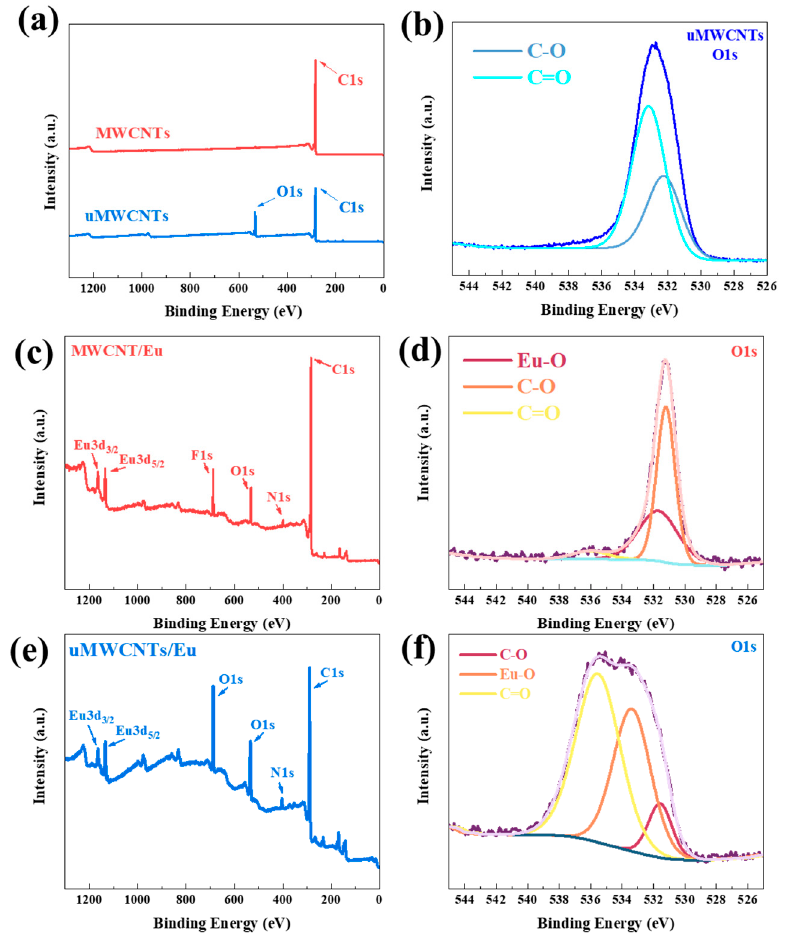
Figure 4. XPS spectra of MWCNTs ( a ); uMWCNTs ( b , c ); MWCNTs/Eu ( d , e ); uMWCNTs/Eu ( f , g ). Table 1. XPS analysis results of MWCNTs/Eu, uMWCNTs/Eu, MWCNTs/Eu and uMWCNTs/Eu.